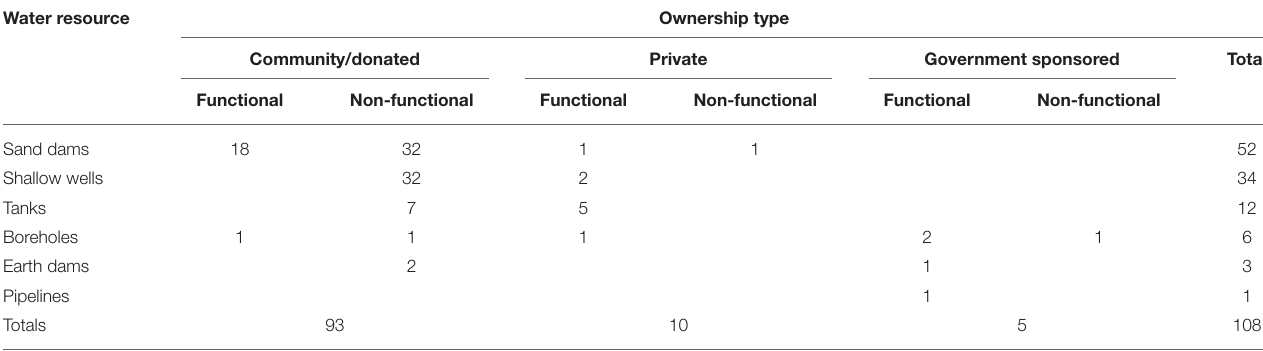
TABLE 1 | Overview of functionality of water projects in Kitui.